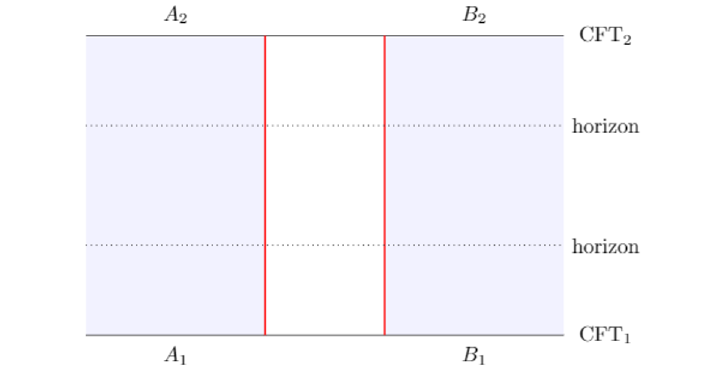
Figure 1 . The pictorial representation of one of the two possibilities of the HRT surfaces cor- responding to region A [ B . We referred to these surfaces as con(cid:12)guration-1. The HRT surfaces (shown as red curves) in this con(cid:12)guration is the union of two surfaces each of which go through the black brane from one asymptotic region to another. The shaded region denotes the entanglement wedge, which is disconnected in this